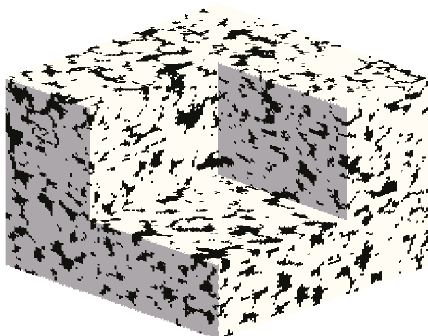
Figure 9: Reconstruction of 3D digital cores using MCMC reconstruction method. Among them, black is the pore part, and white is the skeleton part. The 3D digital cores obtained by the MCMC method have good connectivity of pore space and more concentrated pore